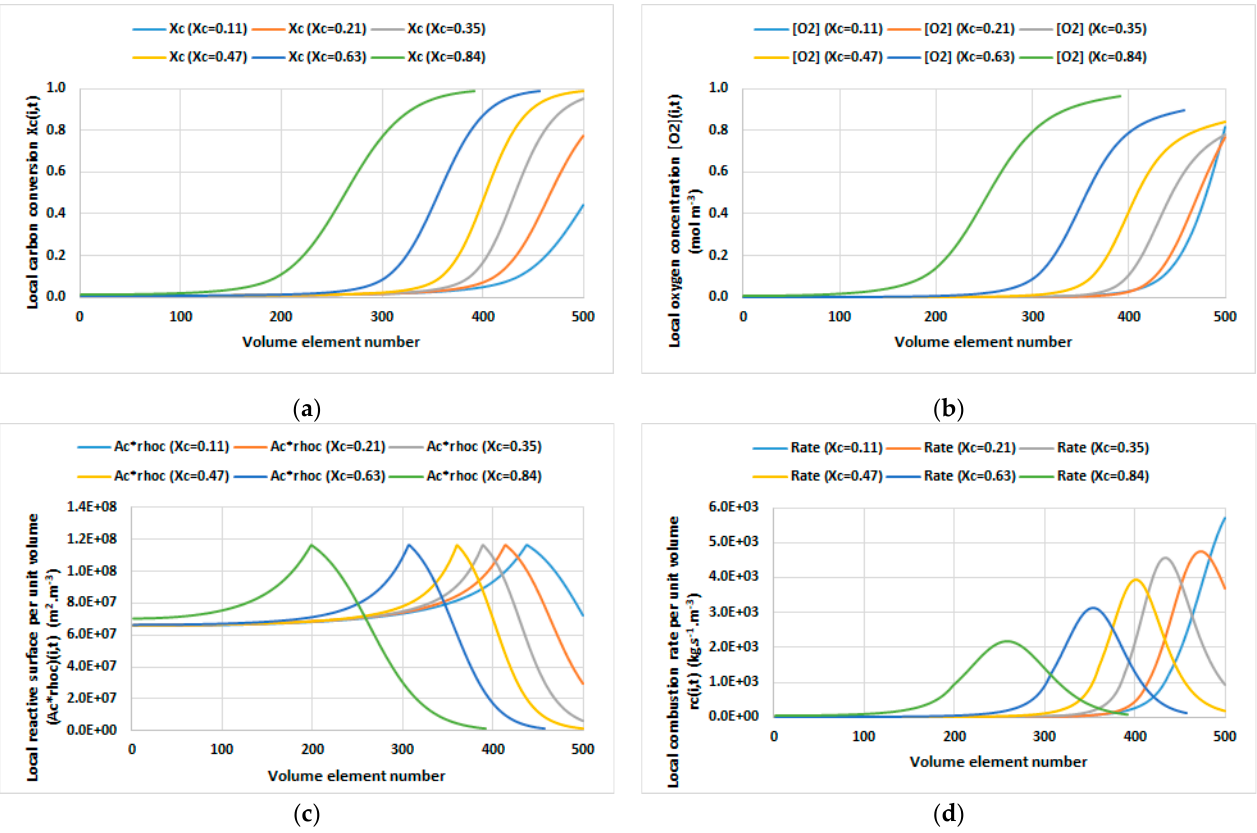
Figure 4. Local carbon conversions 𝑋 (cid:3004) ( a ), oxygen concentrations [𝑂 (cid:2870) ] ( b ), local reactive surface per unit volume 𝐴 (cid:3004) 𝜌 (cid:3004) , ( c ), and local carbon consumption rates 𝑟 (cid:3004) ( d ), at the six chosen times indi- unit volume A C ρ C , ( c ), and local carbon consumption rates r C ( d ), at the six chosen times indicated cated in Table 3, and for the regulation temperature of the reactor equal to 1200 °C. in Table 3, and for the regulation temperature of the reactor equal to 1200 ◦